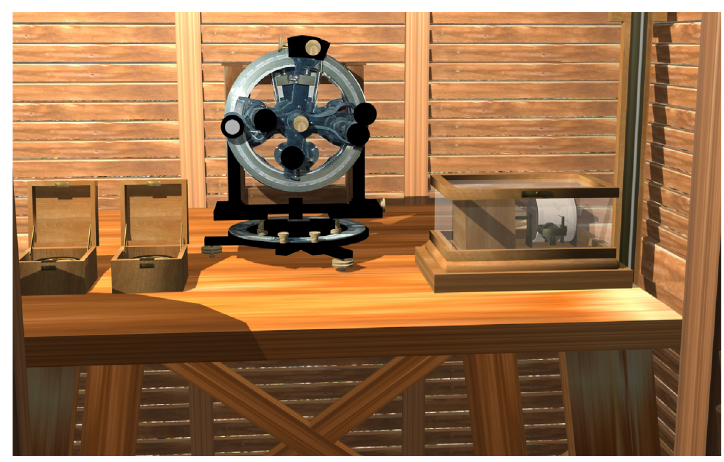
Figure 10. Computer reconstruction of a 19 th century magnetometer.